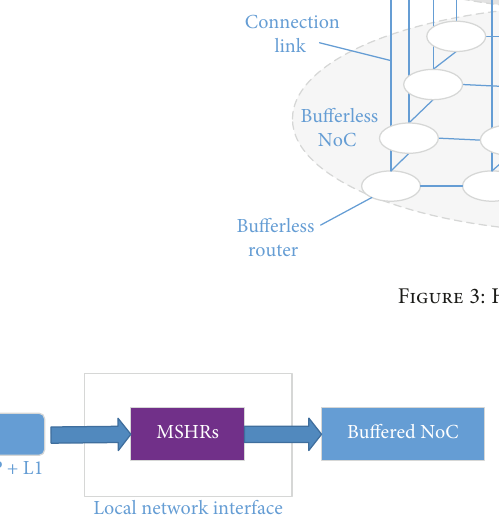
Figure 4: Network interface of the bu ff ered NoC.